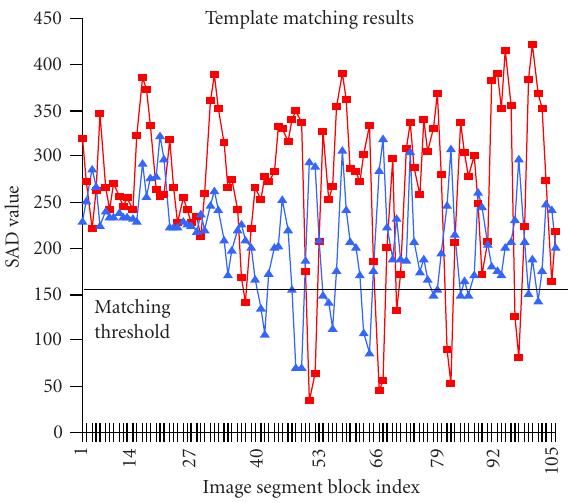
Figure 16: SAD template matching outputs. A threshold of 155 is used to identify the objects in Figure 15.